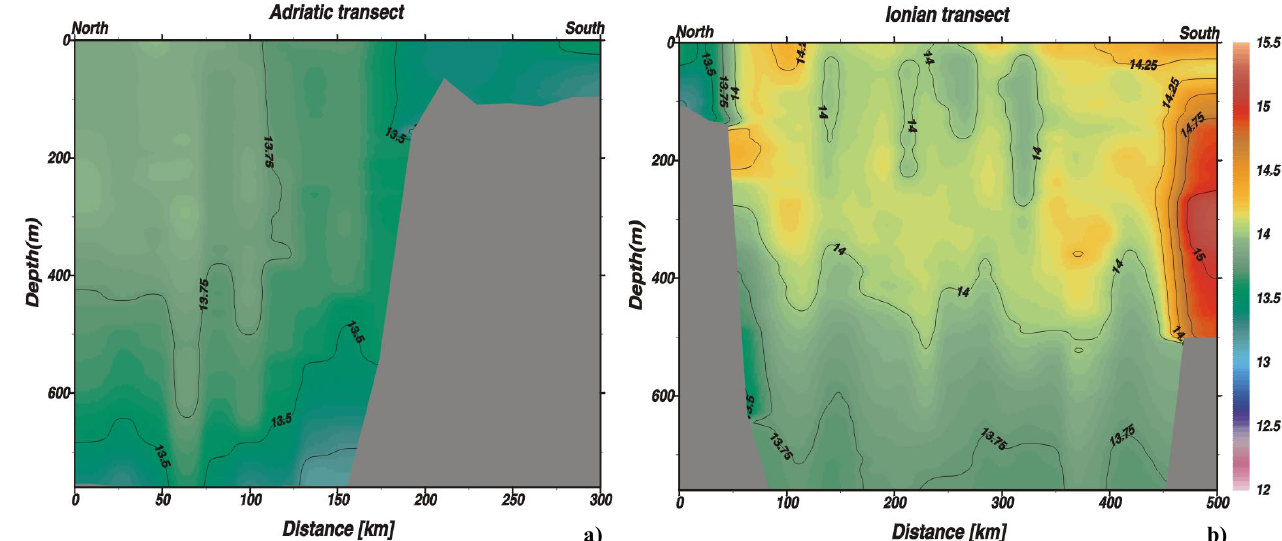
Fig. 9. Temperature vertical sections in March 2000 from Ploce to Malta (track 5) (a) Adriatic transect, (b) Ionian